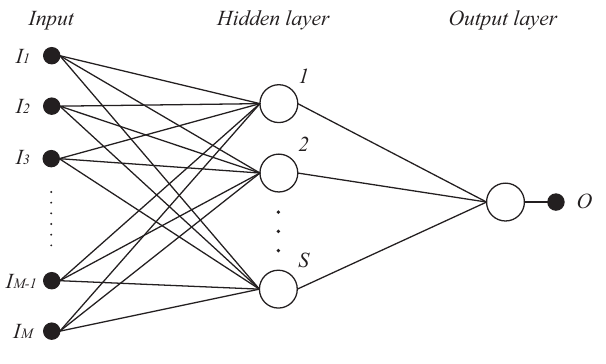
Fig. 4. Architecture of Elman neural network